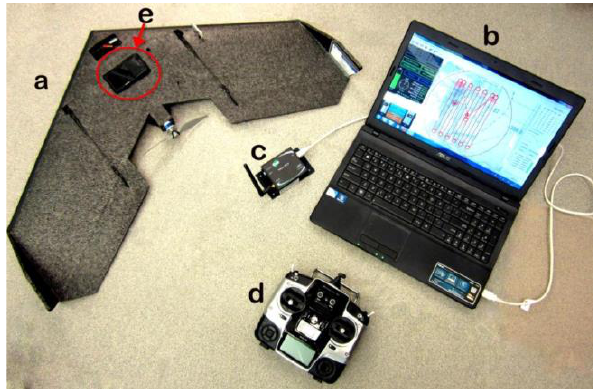
Figure 2. Elements of swinglet CAM system: (a) UAV, (b) ground control station, (c) radiomodem, (d) remote control, (e) camera